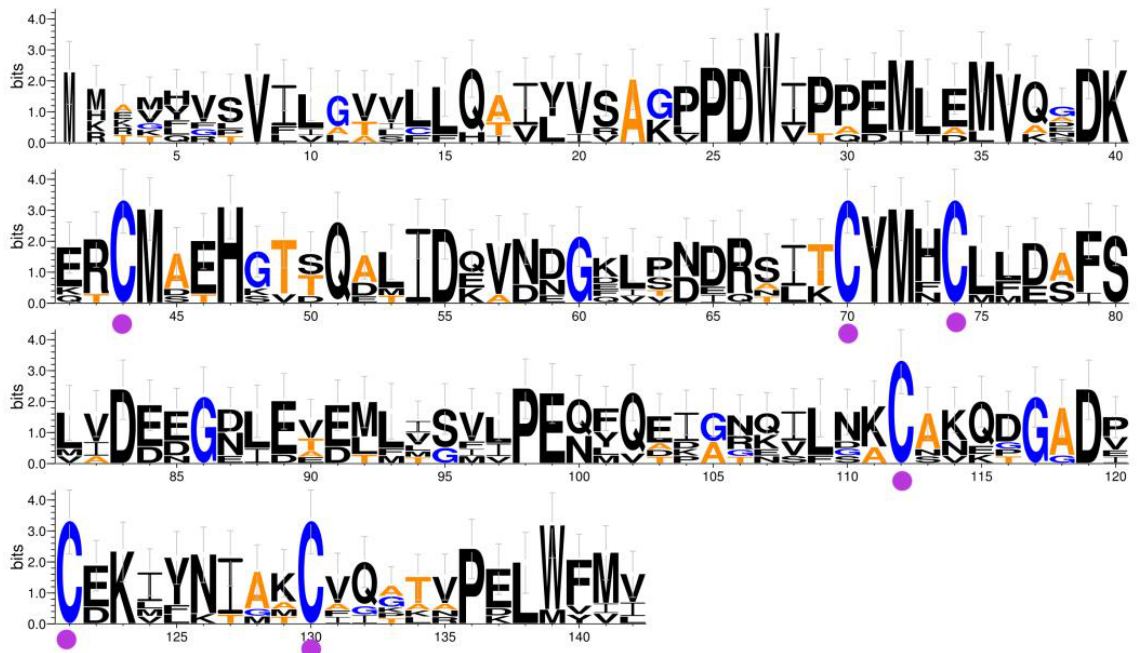
Figure 1. The sequences of SnocOBP9 in S. noctilio and the other six PBPs of Hymenoptera were aligned. Sequence conservation was determined based on the overall height of the stack at that position, and the height of the symbols within the stack suggests the relative frequency of each amino acid at that position. Conserved cysteines are marked with purple dots. The insect species and GenBank accession numbers are the following: Formica exsecta PBP (XP_029680467.1), Belonocnema treatae PBP (XP_033213373.1),